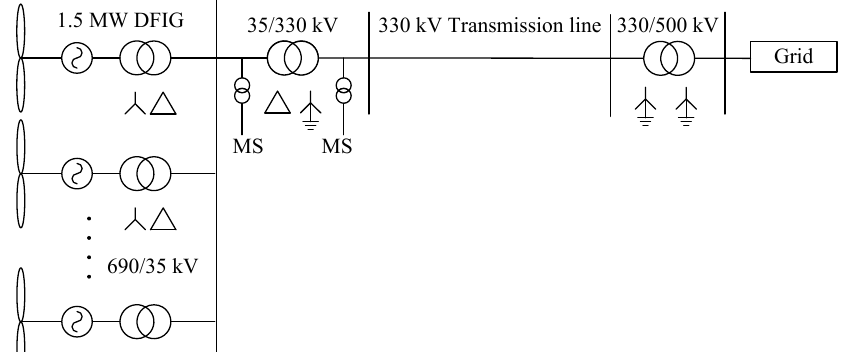
Figure 4. The simulation case based on real wind farms located in Gansu province in China. Grid1.5 MW